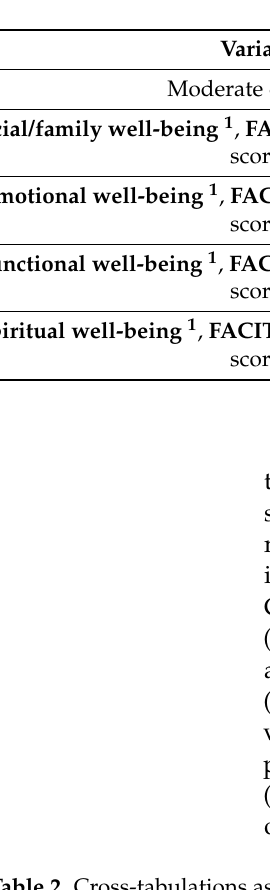
Table 2. Cross-tabulations assessing the relationship between the outcome (mental disorder), predictors (urinary function, social/family, emotional, functional and spiritual well-being, treatment modality), and covariates in a sample of men with a history of prostate cancer diagnosis from the baseline cycle of a Quality-of-Life Maritimes Survey administered between 2017 and 2021, n =